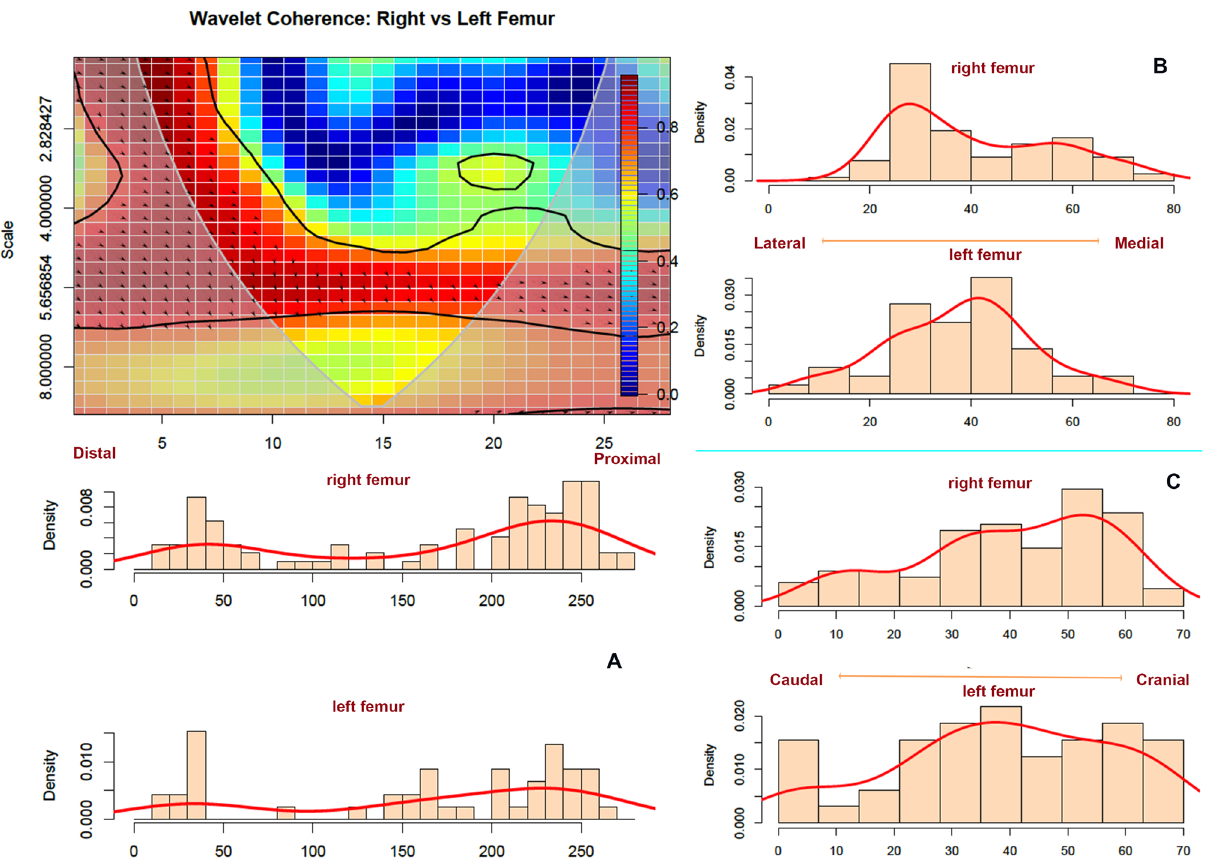
Figure 6. Bivariate wavelet coherence plot showing the correlation of tooth mark damage on the proximal and distal sections of left and right femora in moderate frequencies. Arrows indicate that in these two high- correlation areas, both femoral sides are in phase (i.e., the covary together in the same direction). The right femur is leading (arrows pointing to the right-down or left-up). Binning of histograms is described in Table 3. ( A ) frequency of marks from distal end (left) to proximal (right) end; ( B ) frequency of marks from lateral (left) to medial (right), and, ( C ) frequency of marks on caudal (left) to cranial seems to respond to bone and muscle insertions and ways in which lions deflesh carcasses at this part of the limb. A moderate correlation (> 0.6) between both sides of the element can be found at the level of the proximal articular neck (metadiaphysis) and surrounding the trochanter section (see yellow islands at the level of the 20th-23rd bins in Fig. 6). As was the case of the upper limb bones, radii-ulnae also exhibit a localized tooth mark pattern. The 95% confidence PCA ellipses overlap for both sides is more intense even than with the stylopodials. The only points falling outside the confidence ellipse are those that appear in the form of single marks and are caused stochasti- cally. The wavelet coherence analysis indicates a strong pattern between both sides, with marks clustering in the proximal epiphysis and strong correlation in the exhibition of low-impact modifications (i.e., few isolates marks) in most of the shaft (high scale = low frequency). There is a high frequency of modifications on the proximal end (see black line sloping upwards in Fig. 7), which decreases as we go down the shaft. The low frequency is maintained throughout the length of the shaft. Only because a few more marks have been documented on the distal and proximal ends, do we see a lower scale (i.e., higher frequency) at the beginning and end of the plot. The high correlation spread along the element shaft indicates that both the right and left radii-ulnae display virtually the same modification pattern. Tibiae also show similar tooth-marking patterns when comparing right and left sides of the skeleton. A PCA shows that a 95% confidence ellipse of samples from both sides overlap in most of their areas (Fig. 4). However, it should be remarked that there is more coordinate variation (i.e., variation in distribution) of tooth marks in tibiae compared to the other long bones. The reason may be double. On the one hand, the tibia exhibits the long- est length dimensions of the appendicular skeleton. On the other side, the occurrence of tooth marks outside the area surrounding the tibial crest is commonly in the form of isolated marks that are more prone to occur randomly during defleshing because no muscle insertions occur on the cranial aspect of the element. Only in the proximal caudal side are tooth marks more prone to cluster because of the muscle insertions on that side. A wavelet coherence analysis shows that tibiae show a low density of modifications, similar to radii-ulnae but over a more widespread area. This creates a situation of high correlation between the left and right sides in the location of the few scattered marks (Fig. 8). The correlation is also similar in the proximal and distal ends when